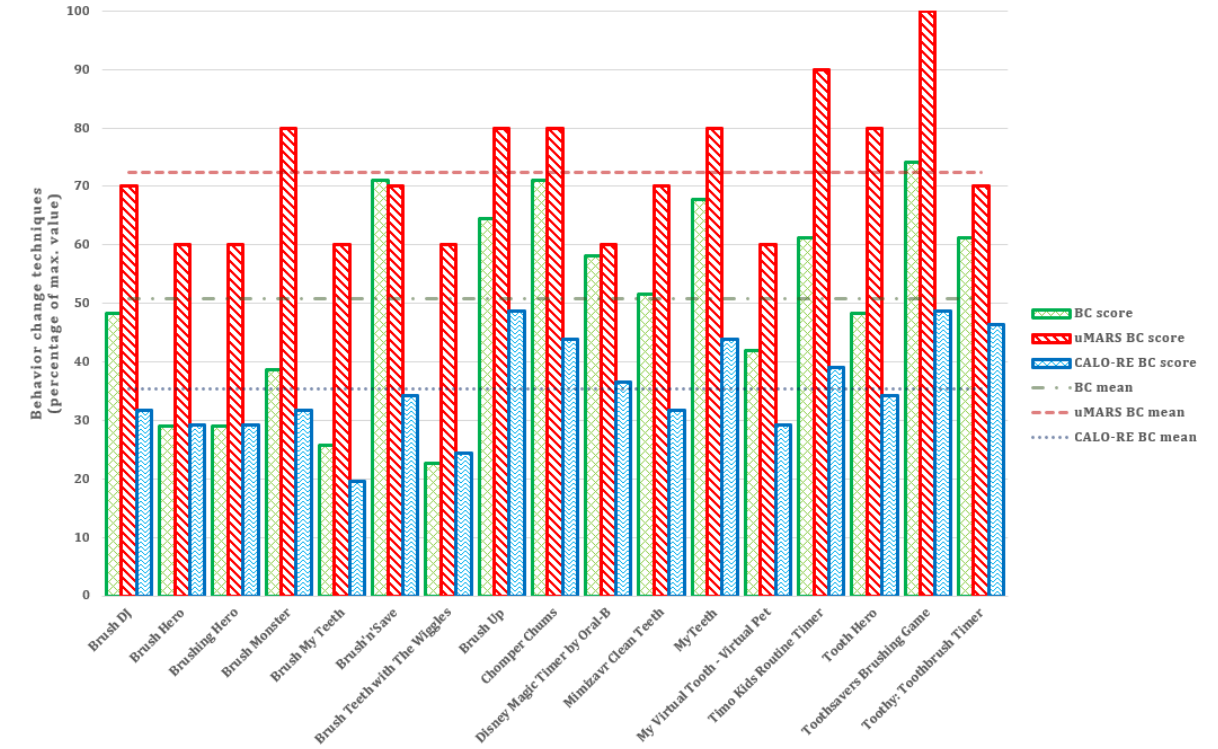
Figure 7. Number of oral hygiene care behavior change techniques. BC: Behavior Change; CALO-RE: Coventry, Aberdeen, and London-Refined; uMARS: Mobile App Rating Scale user